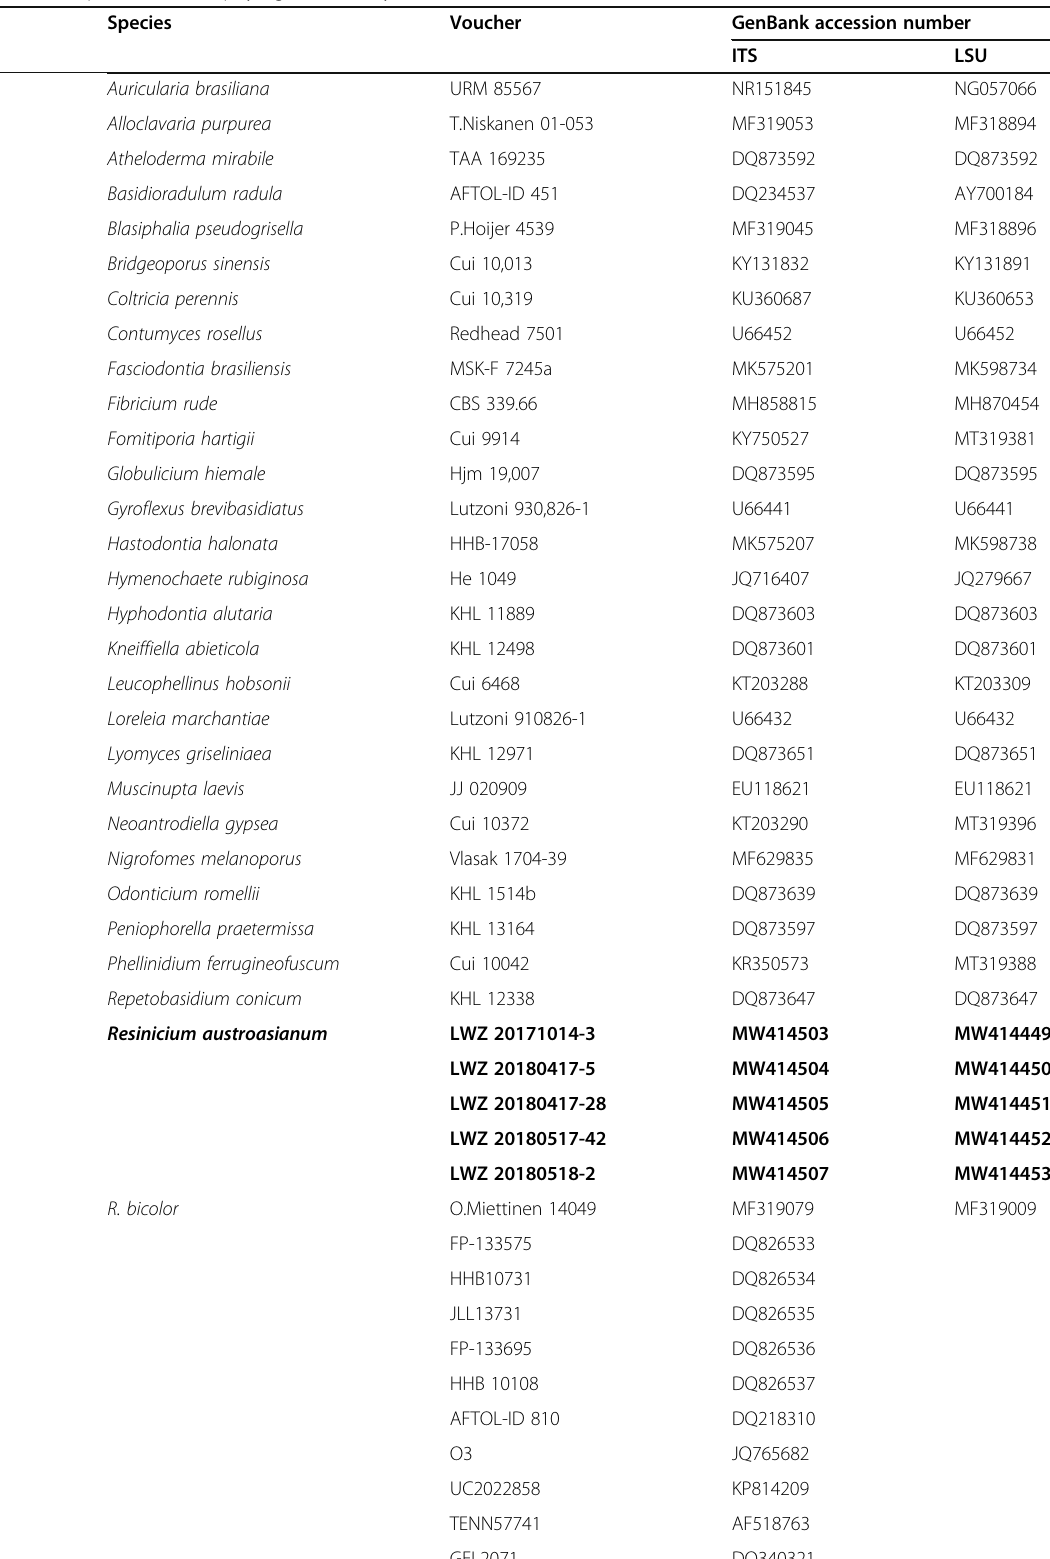
Table 1 Information of species used in phylogenetic